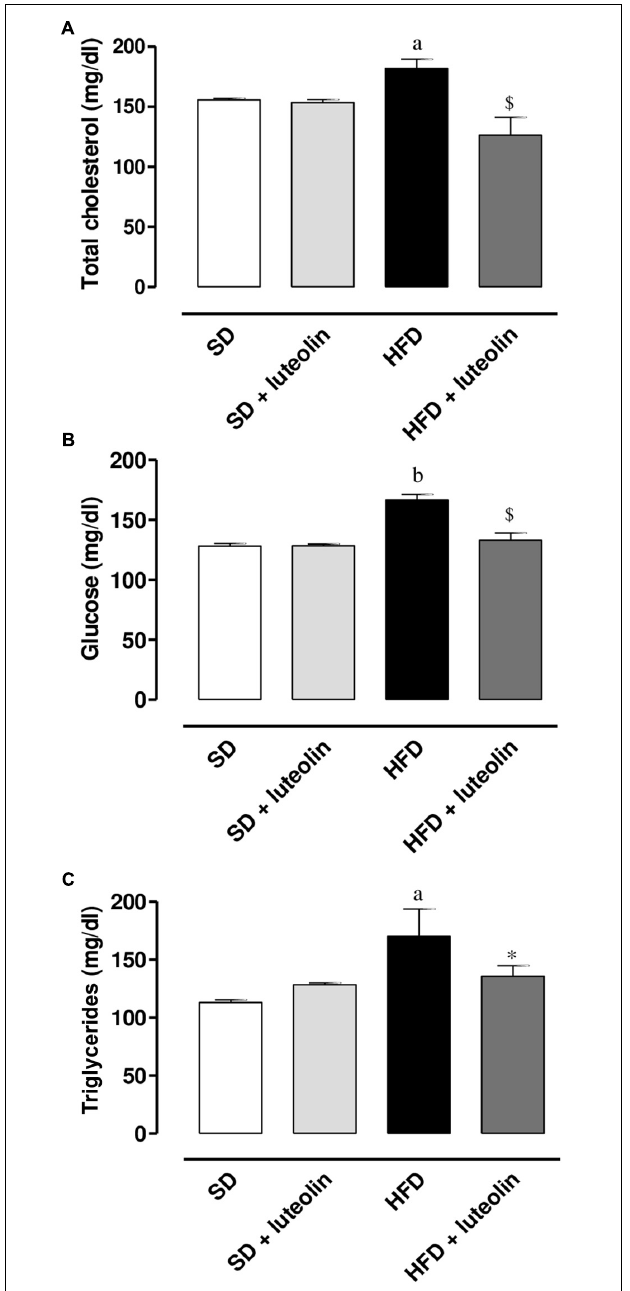
FIGURE 2 | (A) Total cholesterol, (B) glucose, and (C) triglycerides in mice fed with SD, SD plus treatment with luteolin (10 mg/Kg/day), HFD or HFD plus treatment with luteolin (10 mg/Kg/day) for 8 weeks. Each column represents the mean ± SEM of five animals. a P < 0.05, b P < 0.01 significant difference vs. SD; ∗ P < 0.05, $ P < 0.01 significant difference vs. HFD. Statistics: two-way analysis of variance followed by Newman–Keuls